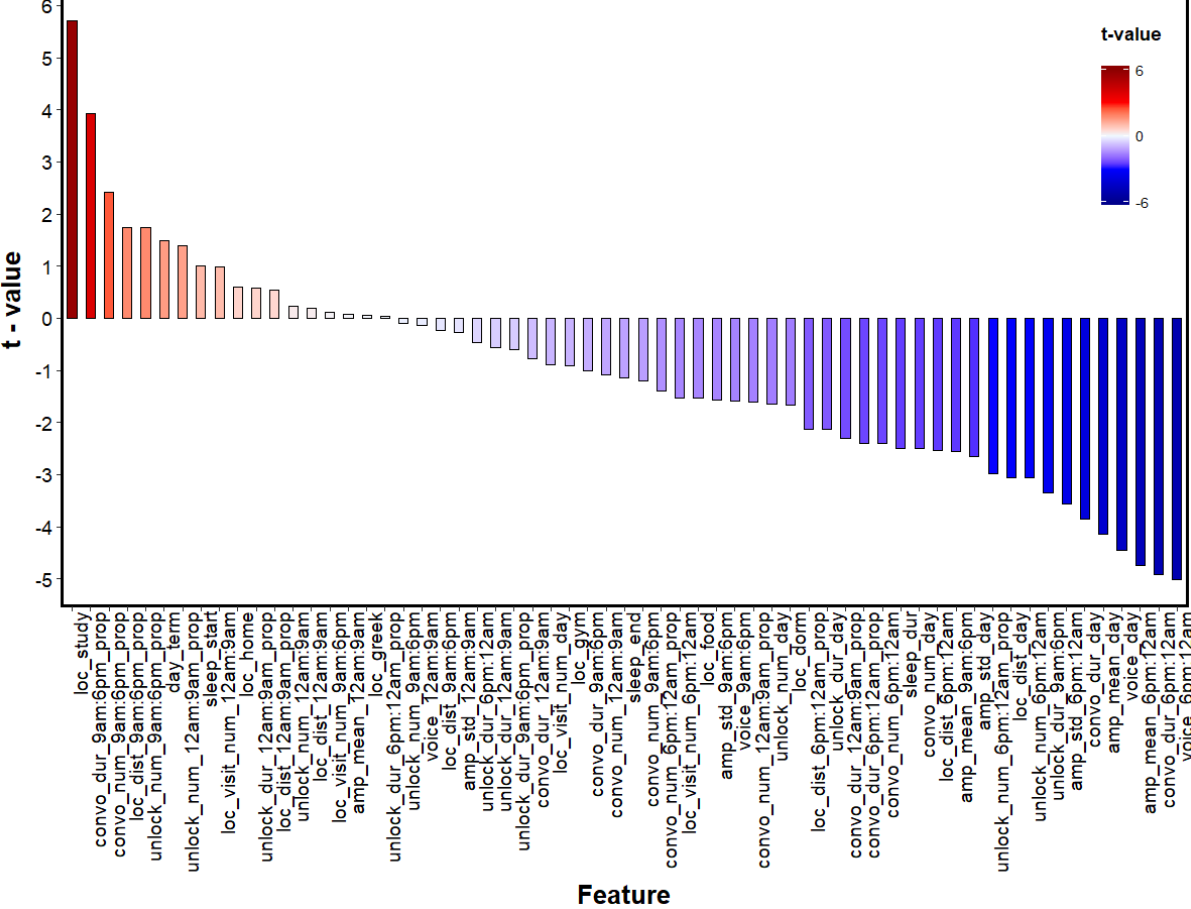
Table 1. Features related to stress as selected by the penalized generalized estimating equations (PGEE) analysis.